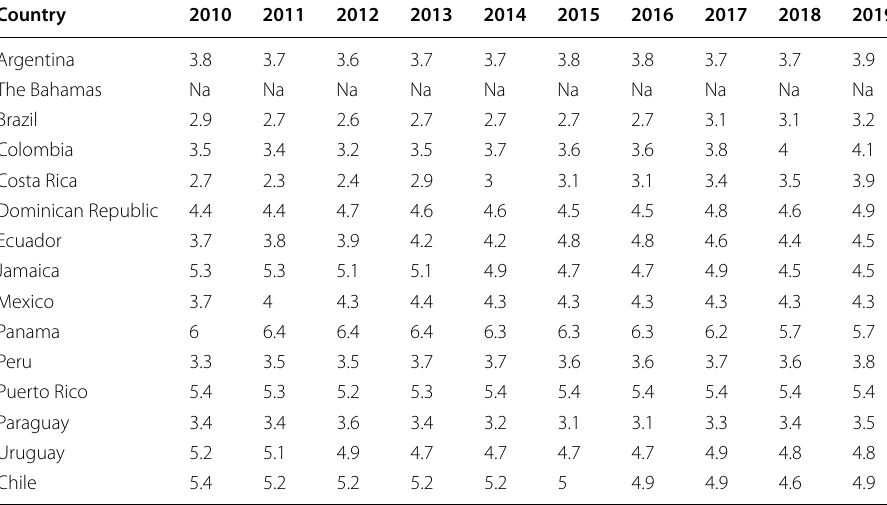
Table 2 Quality of Port Infrastructure among the 19 top Port countries in Latin America and the Caribbean. Source : World Bank (2020)